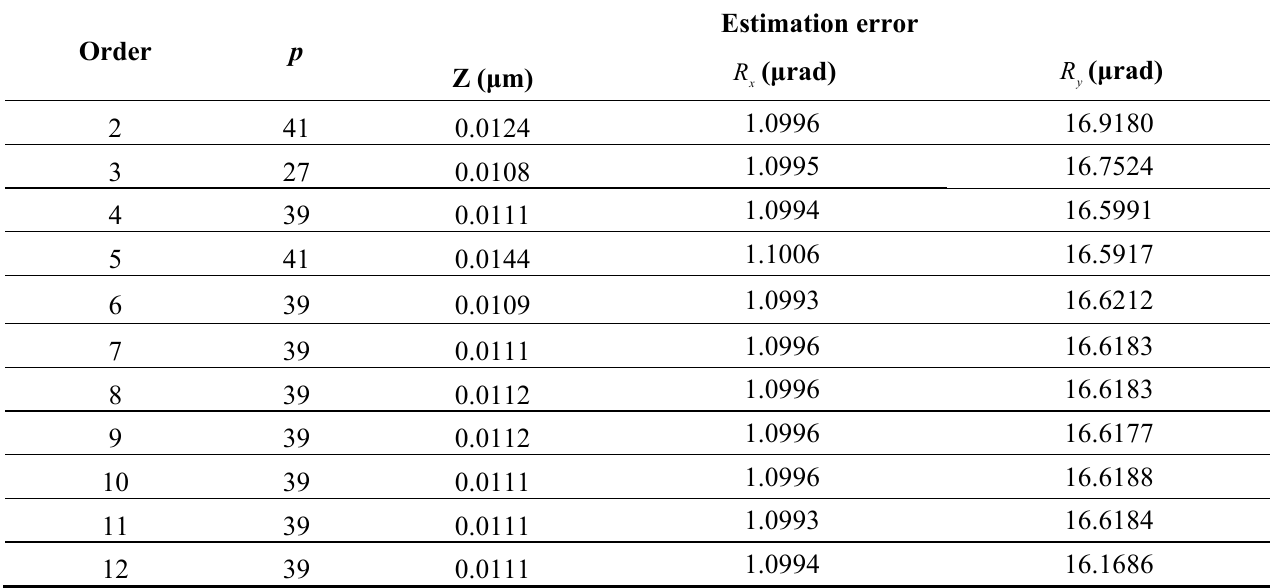
Table 6. Estimation error from the chirp inputs in channel 3.